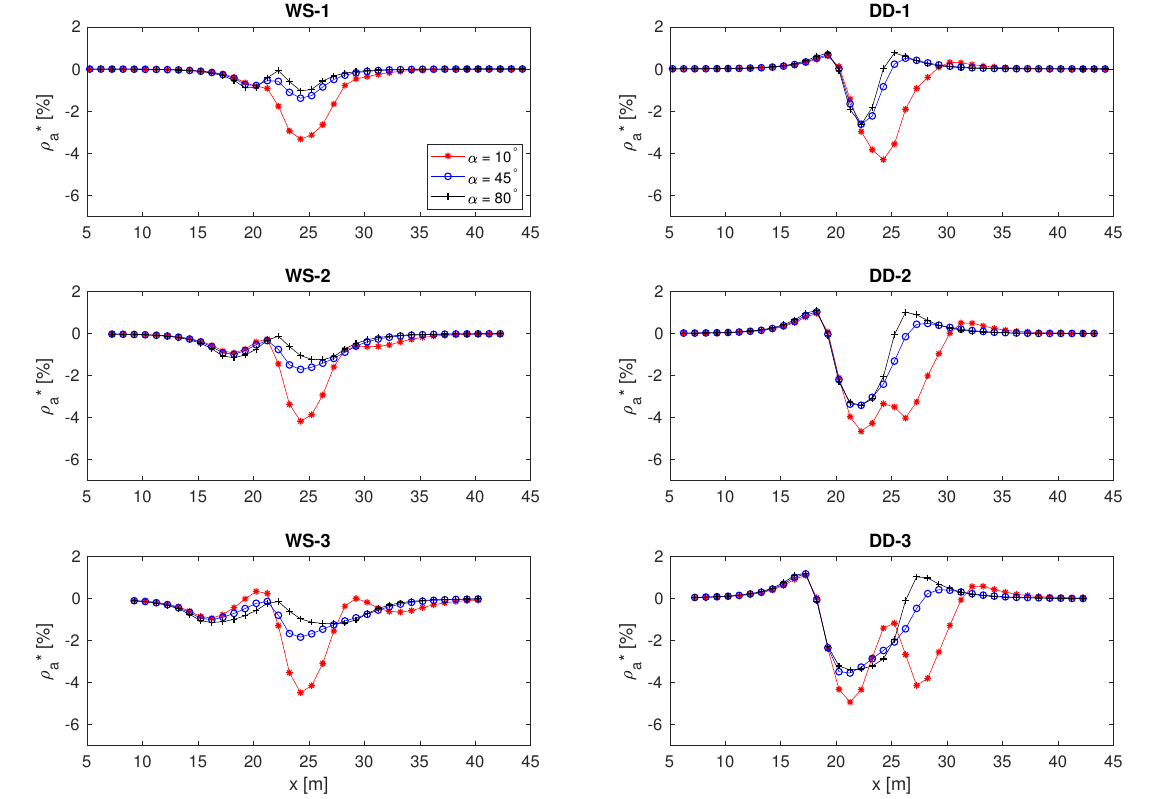
Figure 3. Apparent resistivity anomaly ρ ∗ a (in %) as a function of horizontal position for a single, 1-mm-aperture fracture having length (cid:96) = 5 m, electrical resistivity ρ f = 10 Ω · m, and hosted in bedrock having resistivity ρ b = 10,000 Ω · m. The fracture is covered by a 1 m thick layer of overburden, having resistivity ρ o = 1000 Ω · m. Anomalies for fracture angles of 10 ◦ , 45 ◦ , and 80 ◦ are shown, corresponding to Cases 1, 2, and 3 from Table 1, respectively. Measurement configurations are denoted by WS (Wenner-Schlumberger) or DD (dipole-dipole) followed by the spacing factor ( n =